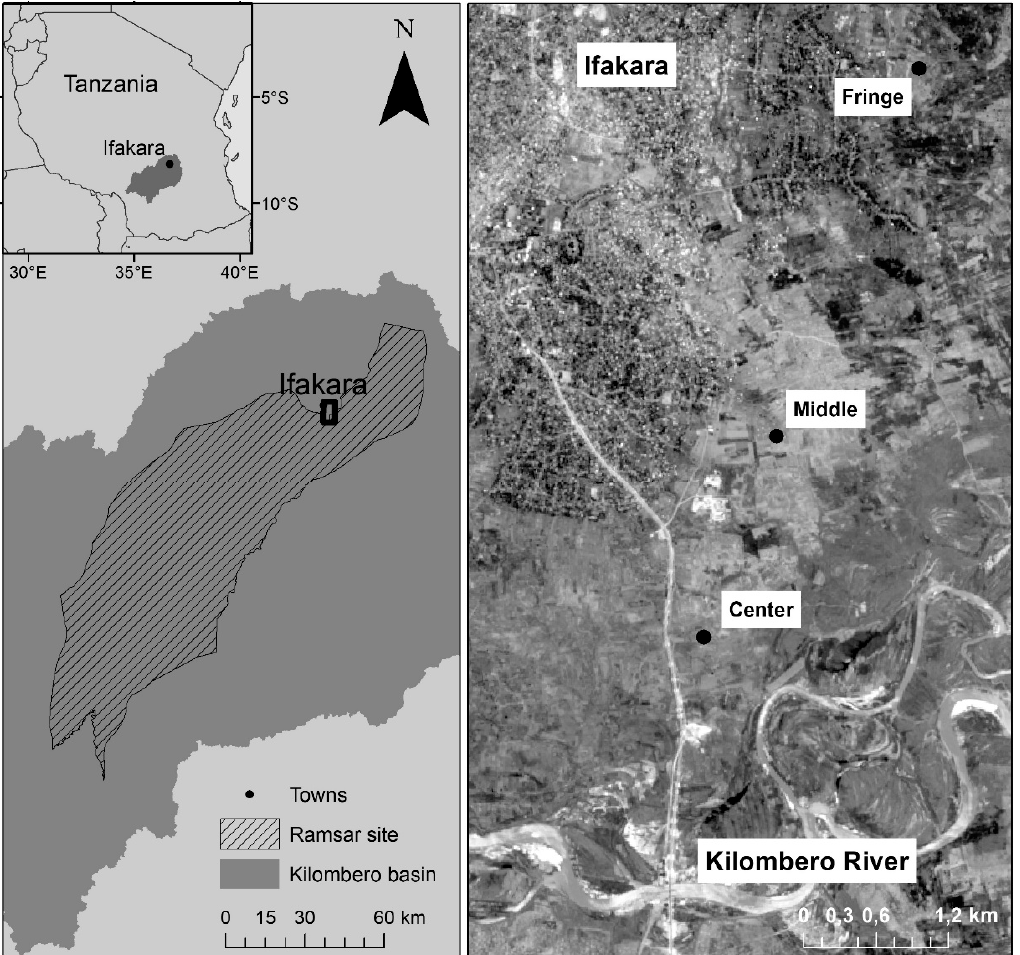
Figure 1. Location of the experimental sites in the Kilombero floodplain. The fringe position is furthest from Kilombero River, while the center position is closely located near the river.